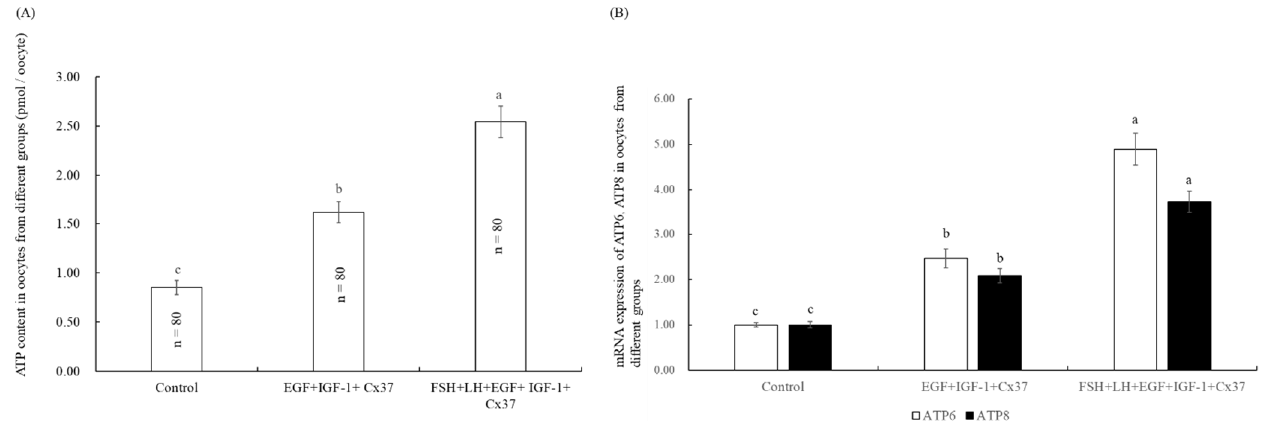
Figure 3. Effect of the combination treatment of EGF, IGF-1, and Cx37on mitochondrial function in bovine oocytes. ( A ) Effect of the combination treatment of EGF, IGF-1, and Cx37 on ATP content in bovine oocytes. ( B ) Effect of the combination treatment of EGF, IGF-1, and Cx37 on mRNA expression of ATP6 and ATP8 level in bovine oocytes. a, b, c Values with different superscripts indicate significant differences between groups ( p < 0.05).